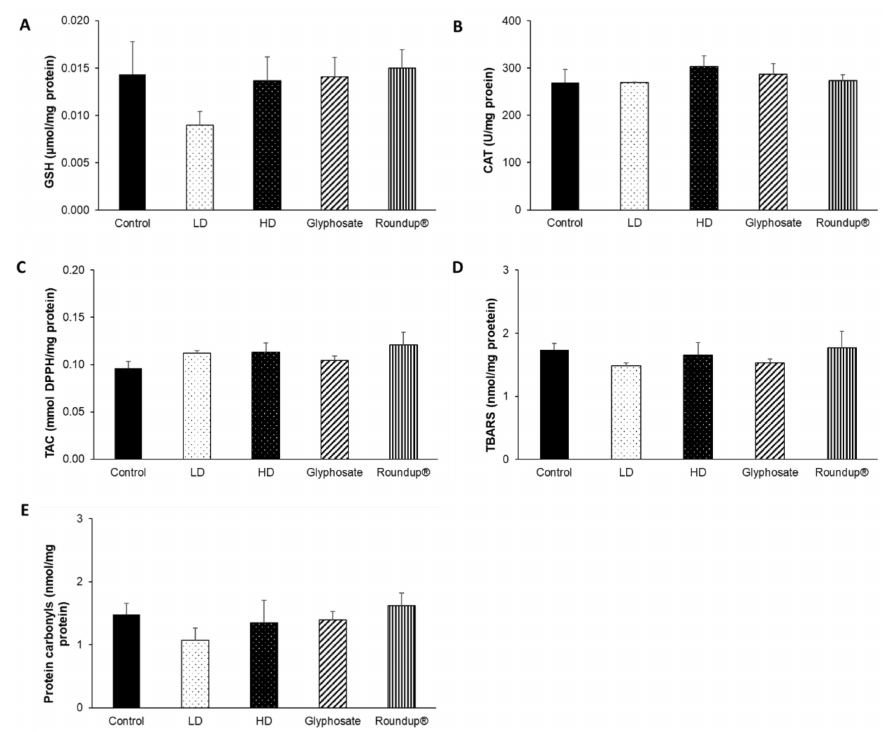
Figure 9. The effects of 12-month exposure of New Zealand rabbits to the EDs mixture, glyphosate, and Roundup ® on left kidney GSH concentration ( A ), CAT activity ( B ), TAC levels ( C ), TBARS levels ( D ), and protein carbonyls concentration ( E ).